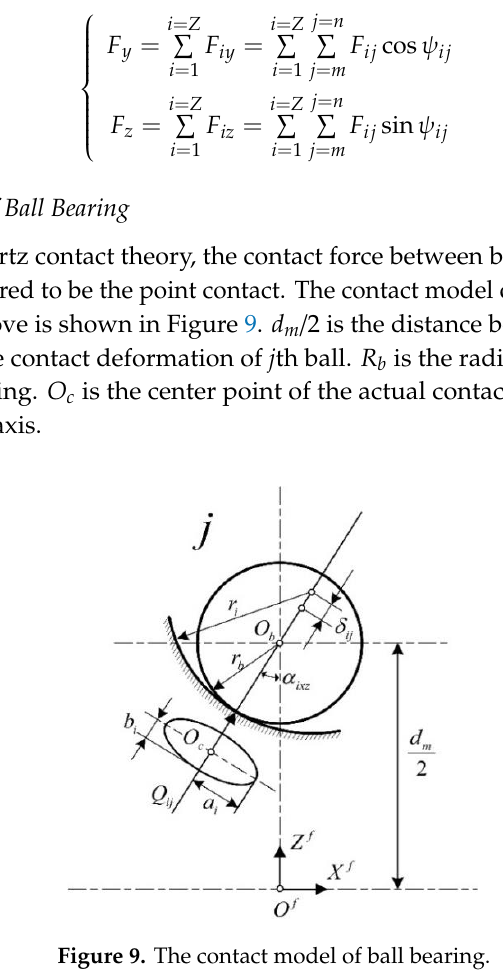
Figure 9. The contact model of ball bearing.